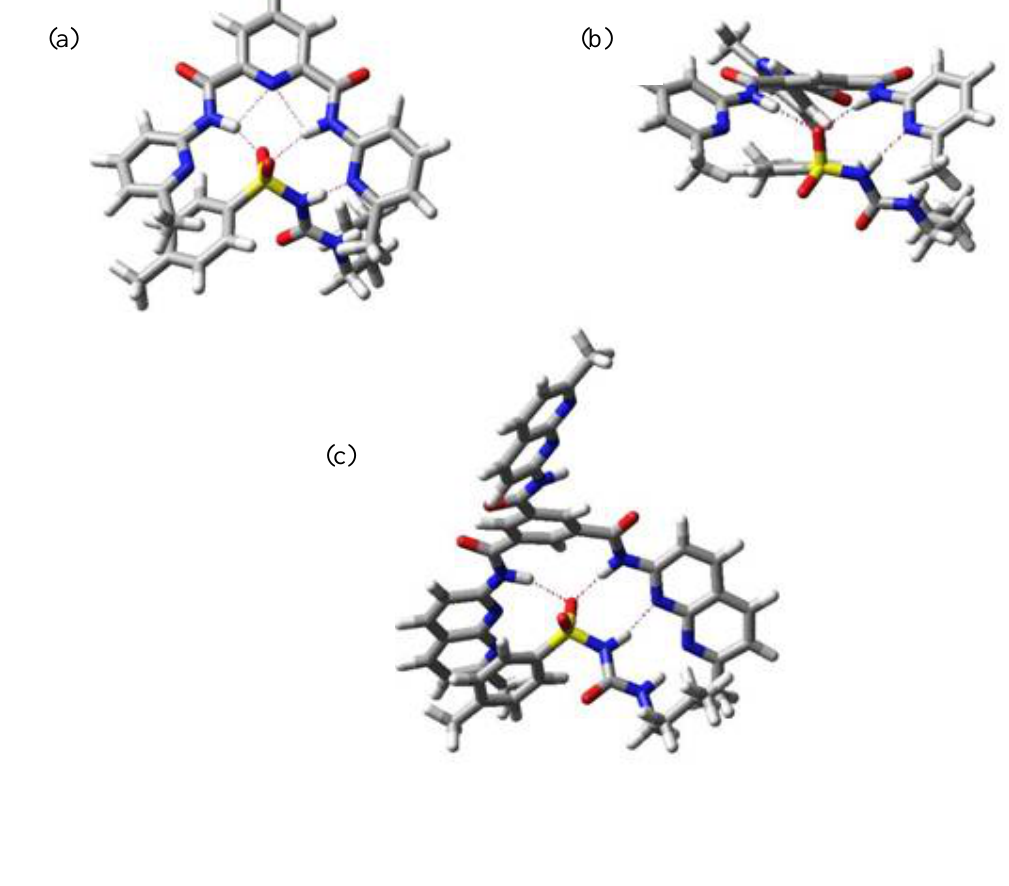
Figure 5. Minimum energy structure for complexes II : 1 (a), III : 1 (b) and IV : 1